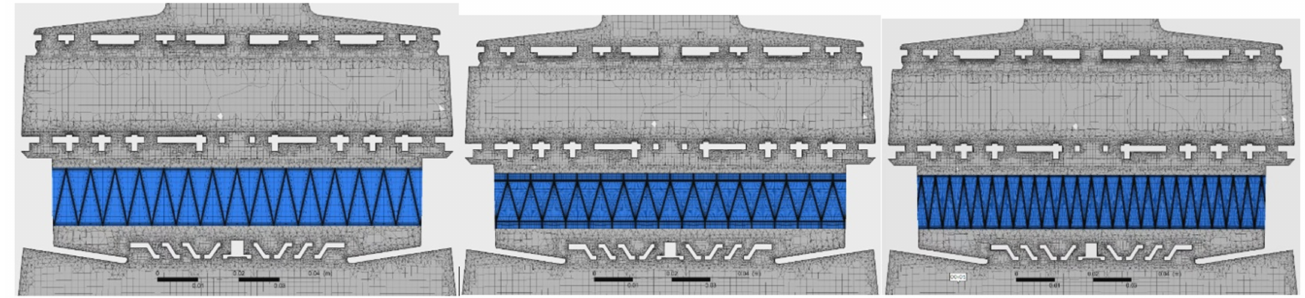
Figure 16. Parametric changes of pleated filter. From the left to right: changes of mesh density, pleats height and pleats